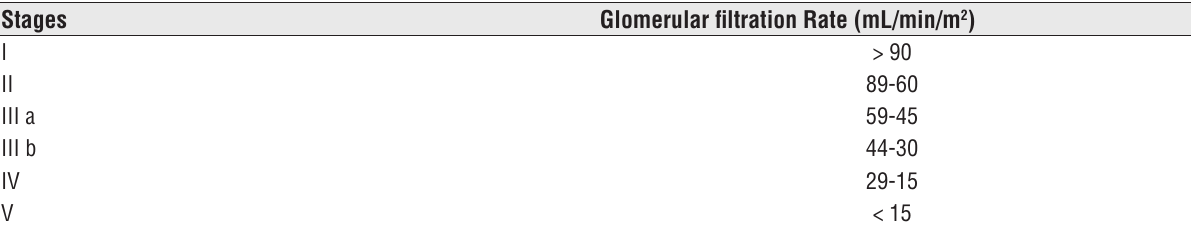
In the absence of evidence of kidney damage, stage I and II do not fulfill the criteria for Chronic Kidney